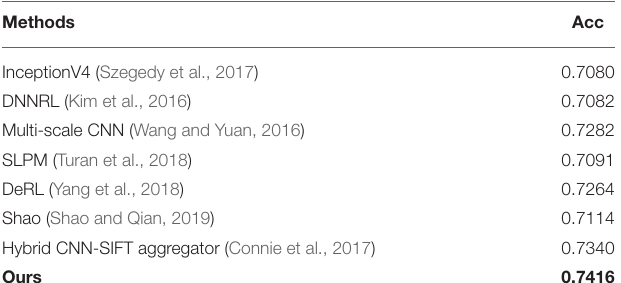
TABLE 2 | Comparison of recognition rates of different algorithms on FER2013 dataset. Methods